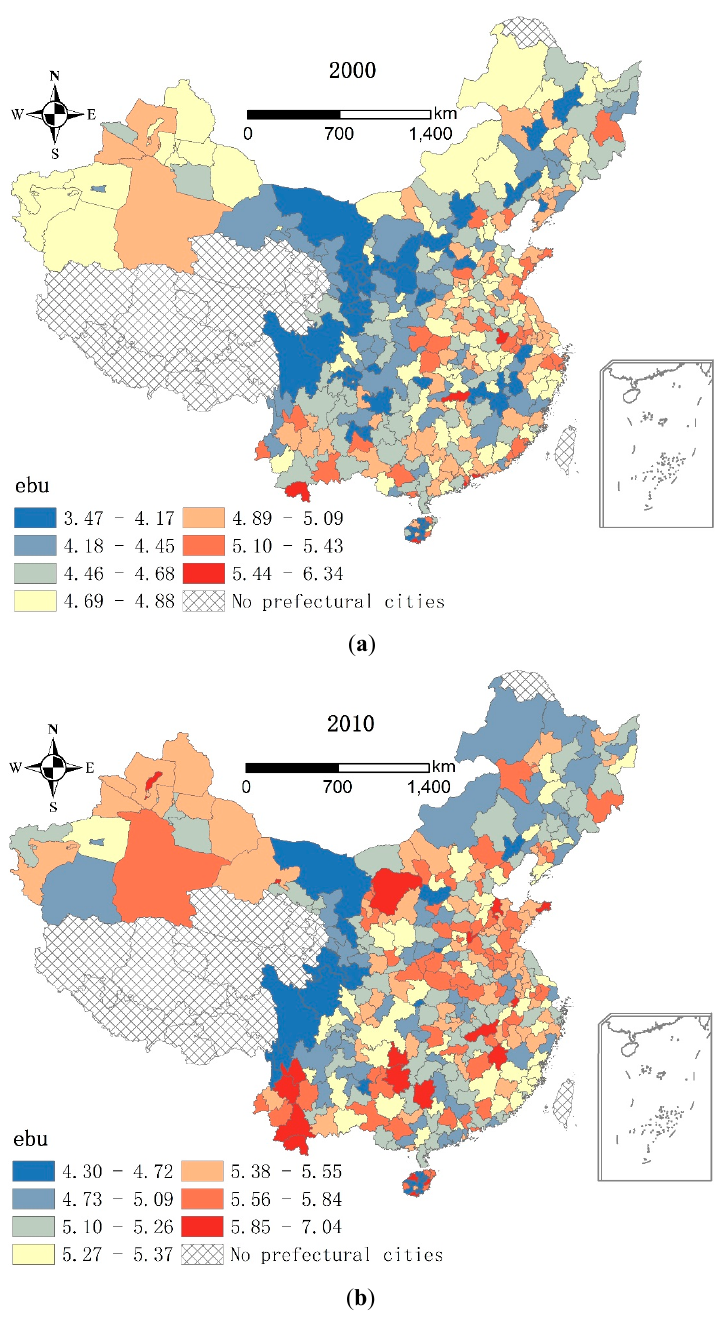
Figure 3. Environmental benefits of urban land use in the prefectural cities, China, 2000 and 2010.